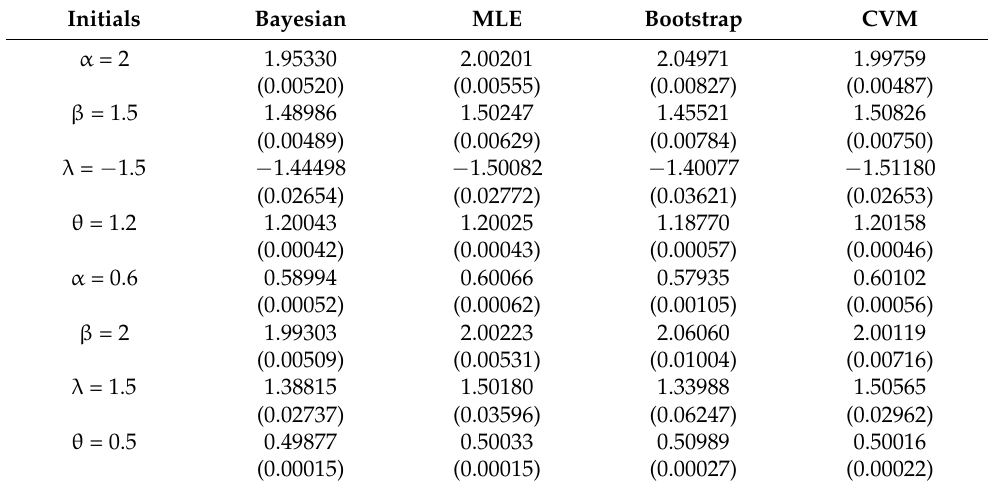
Table 6. The results of the AVs and their corresponding MSEs (in parentheses) for n =